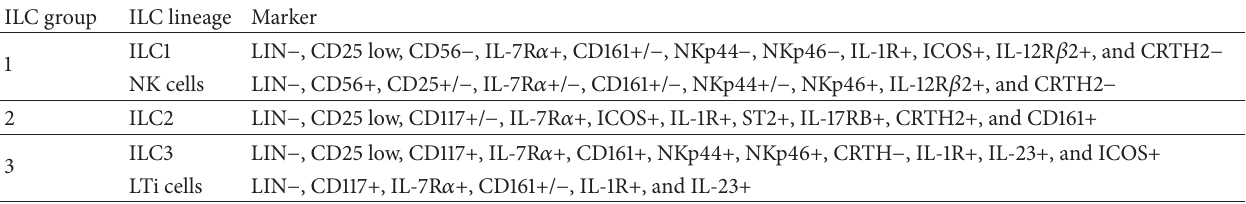
Table 1: Markers expressed by various subsets of innate lymphoid cells